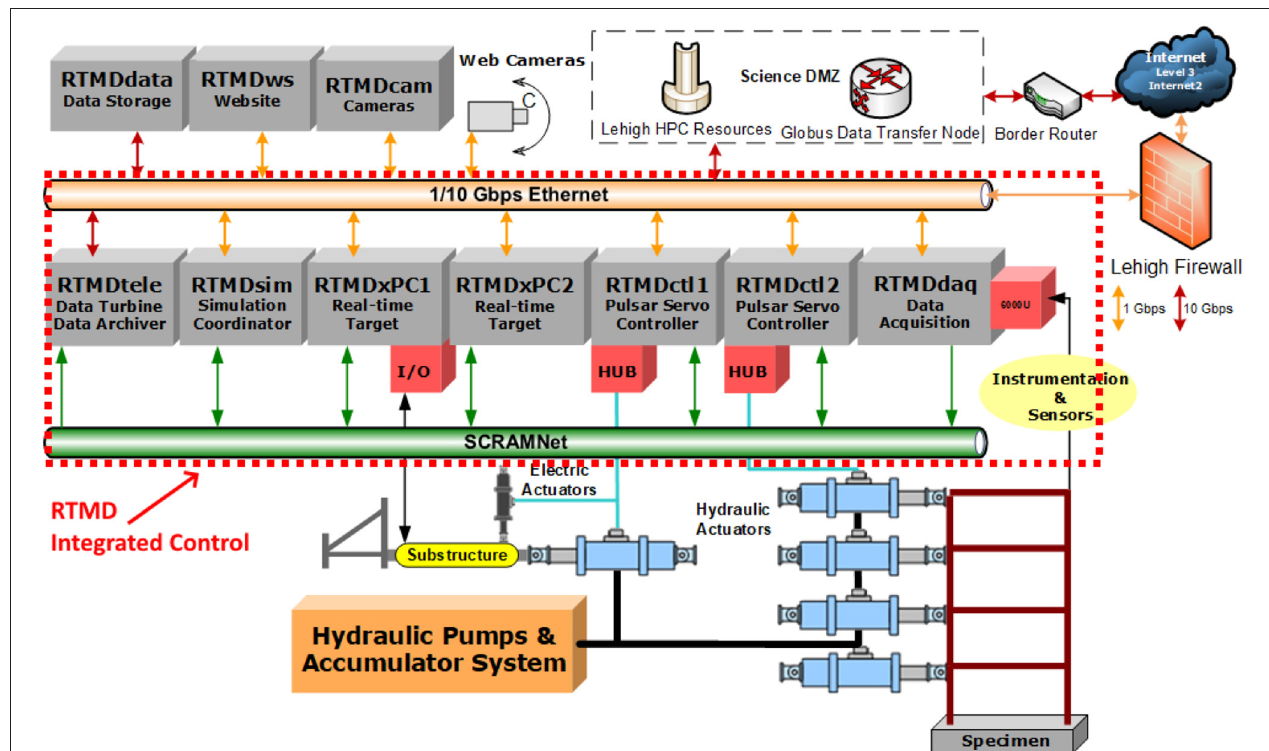
FIGURE 3 | NHERI Lehigh EF real-time integrated control